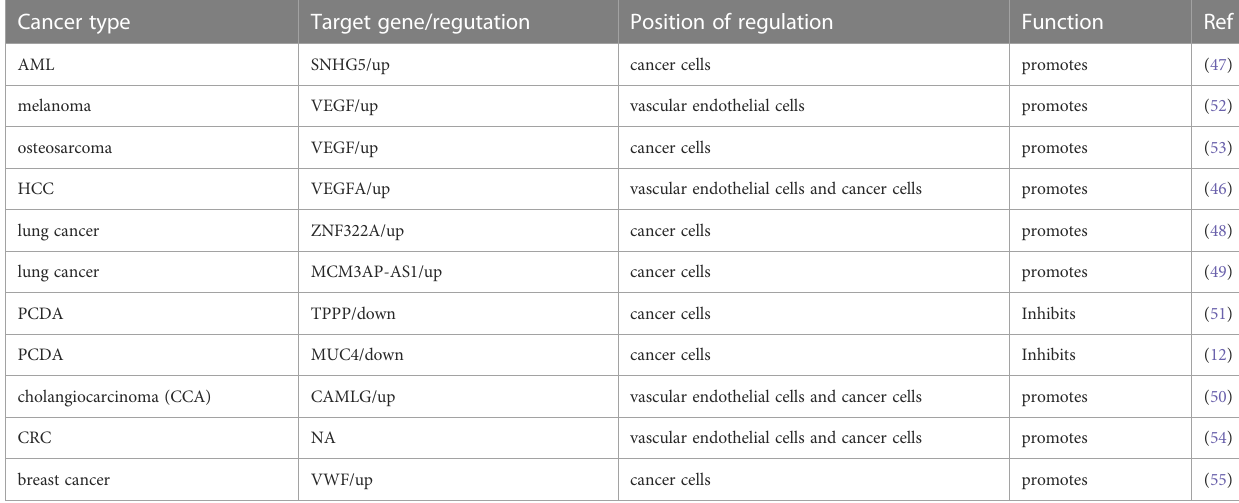
TABLE 2 The target gene and mechanism of YY1 on angiogenesis. Cancer type